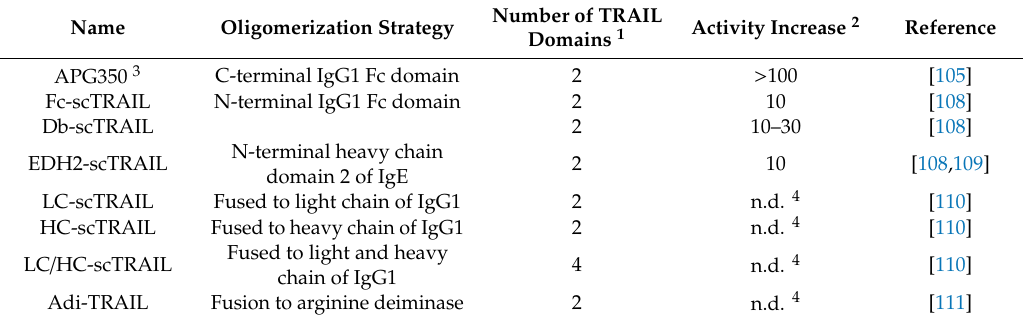
Figure 5. Domain architecture of oligomeric TRAIL fusion proteins ( A ). Apoptotic TRAILR1 / 2 clustering is illustrated in ( B ) for Fc-scTRAIL. Table 4. Fusion proteins with two or more “TRAIL trimer”